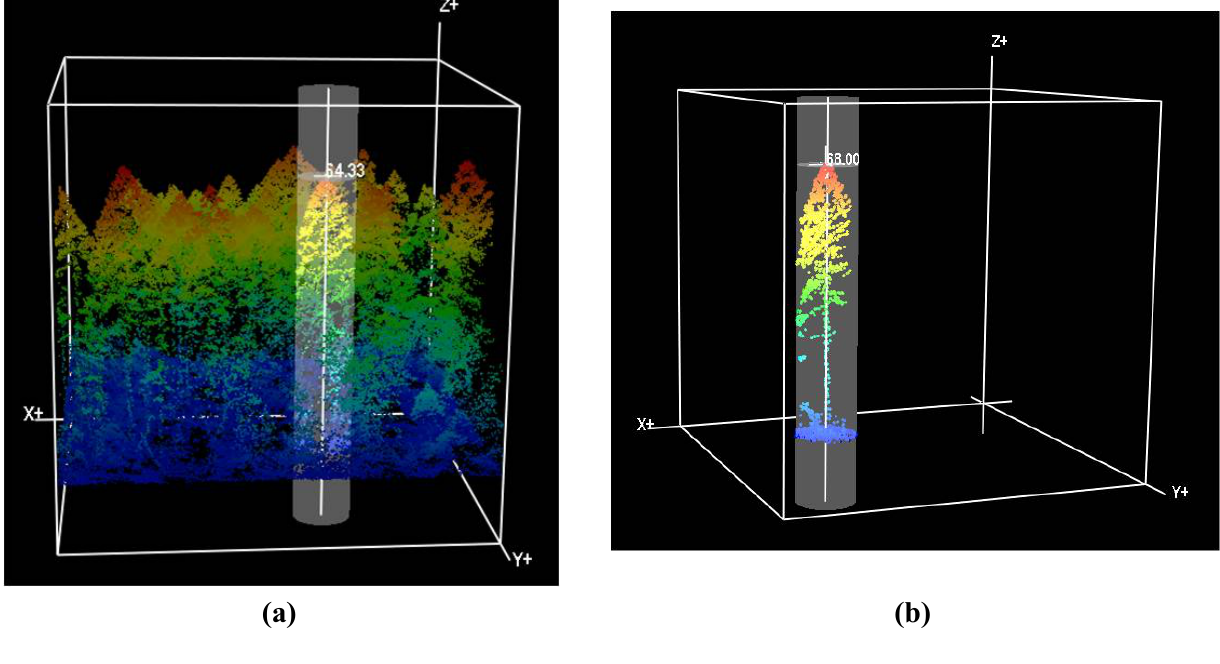
Figure 4. (a) FUSION LiDAR Data Viewer (LDV) measurement window displaying tree height measurement capability. Tree X and Y location, height, crown width, crown base height, and elevation at tree base may be measured and saved to file; (b) FUSION measurement marker surrounding a single LiDAR